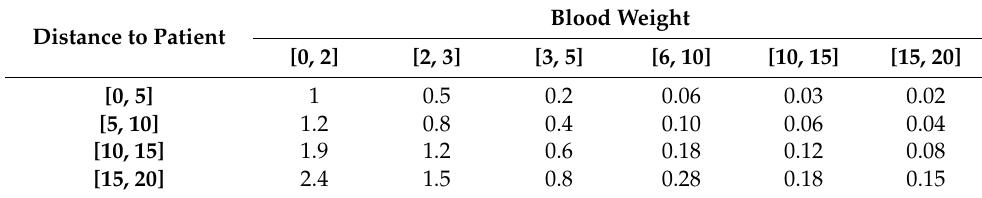
Table 2. The ratio between blood and water